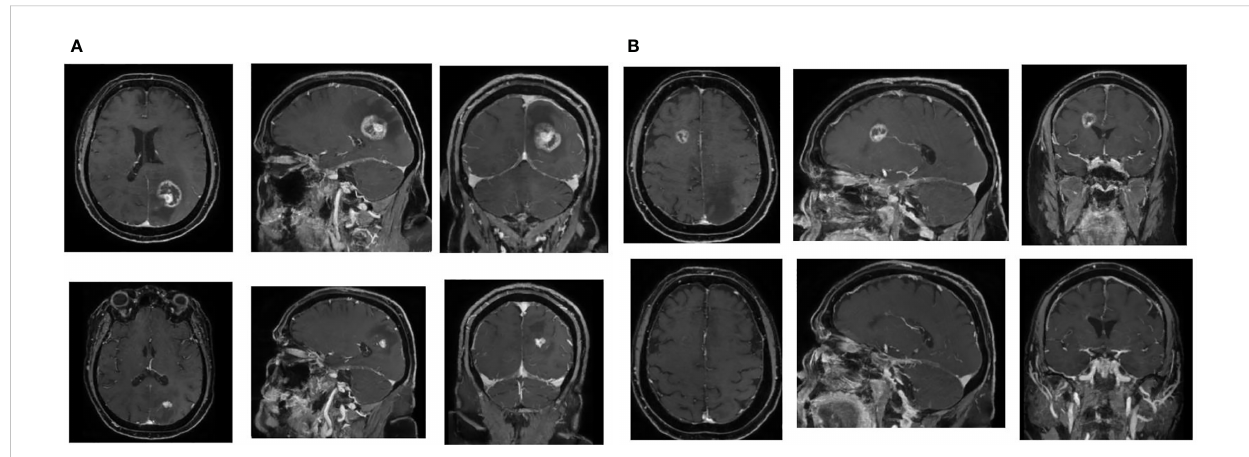
FIGURE 2 Impressive volume reduction of two brain radionecrosis areas. (A) Left occipital lesion. Above, MRI before cabozantinib (9 months after SRS). Below, MRI after cabozantinib (13 months after SRS). (B) Right frontal lesion: Above, MRI before cabozantinib (9 months after SRS). Below, MRI after cabozantinib (13 months after